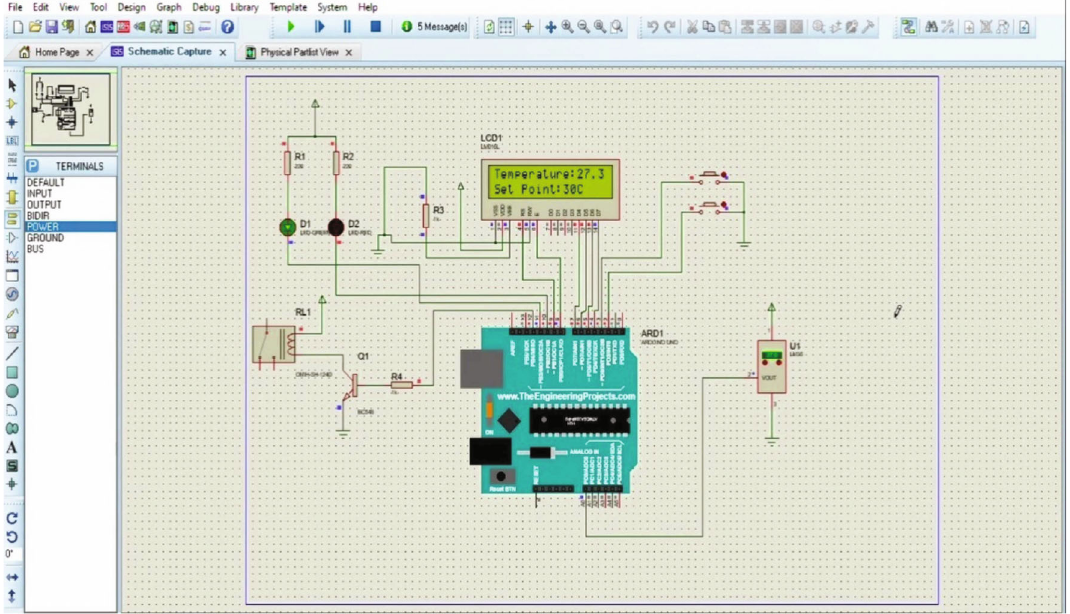
Figure 7: Heater is in onstate, as the temperature did not exceed the set